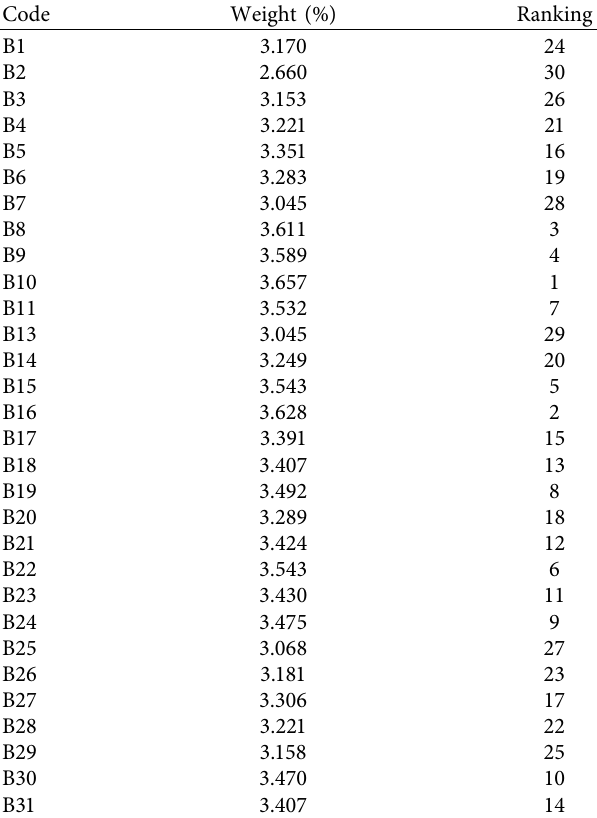
Table 6: Weights and rankings of thirty original observable variables.